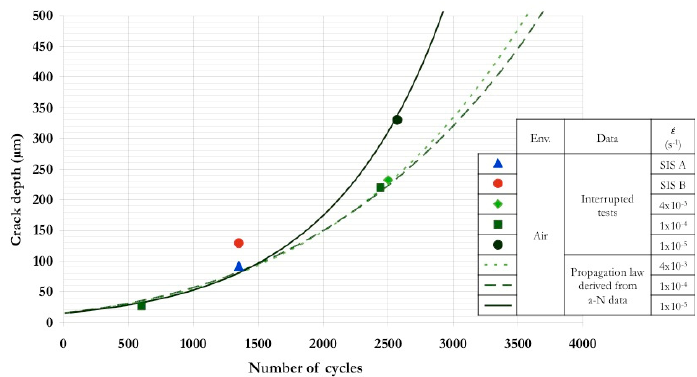
Figure 5. Fracture surfaces with details of the initiation area in test in air at Δε t /2 = 0.6% interrupted after 1350 cycles using the ( a ) SIS A signal and ( b ) SIS B signal.